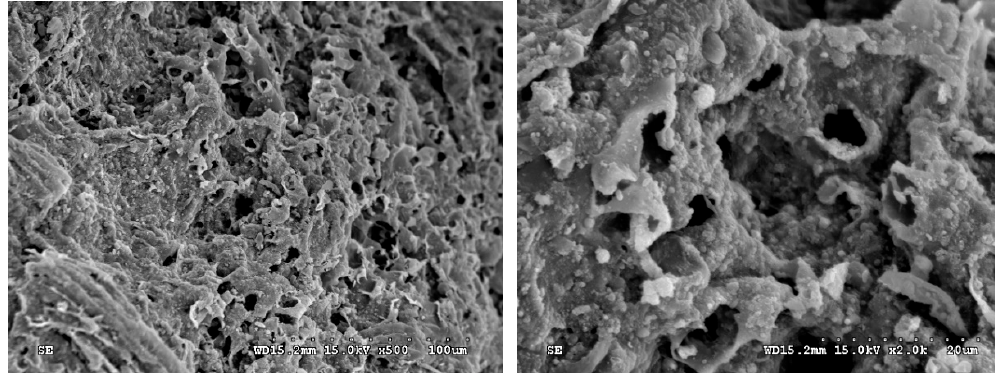
Figure 2. SEM images ( left : ×500; right : ×2000) of DM-BC.